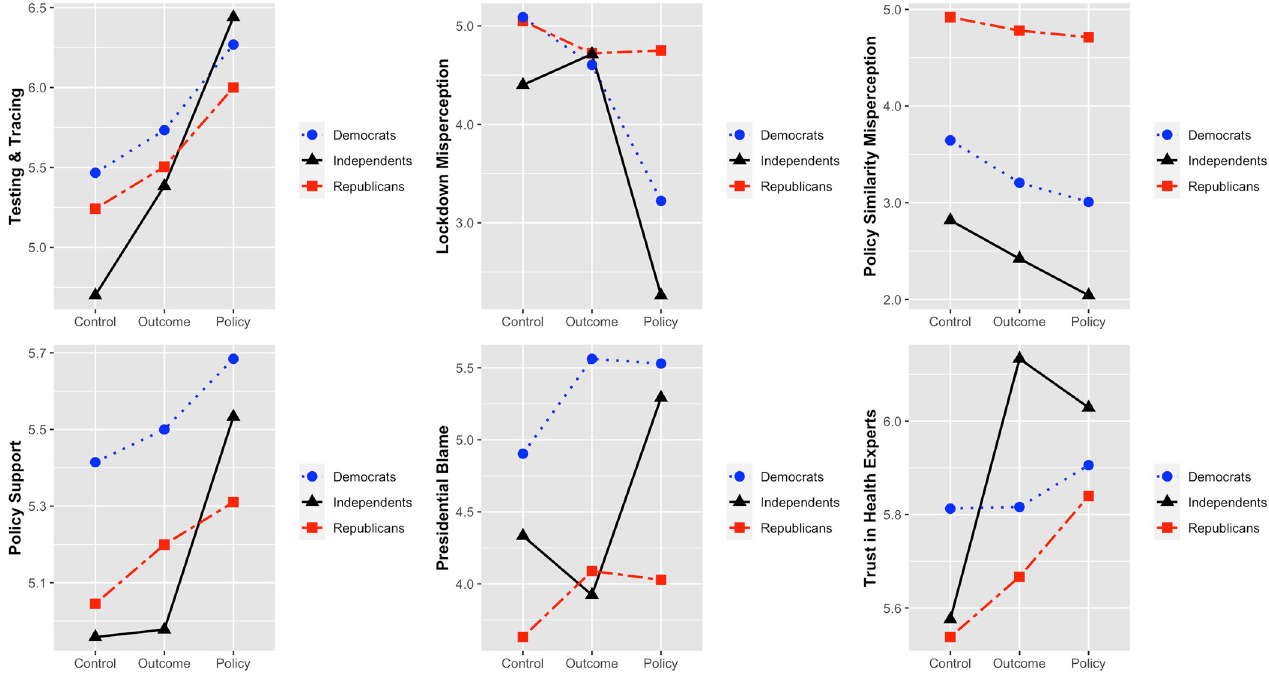
Fig 1. Effect on knowledge of policy difference, support for policy, and trust toward health experts.